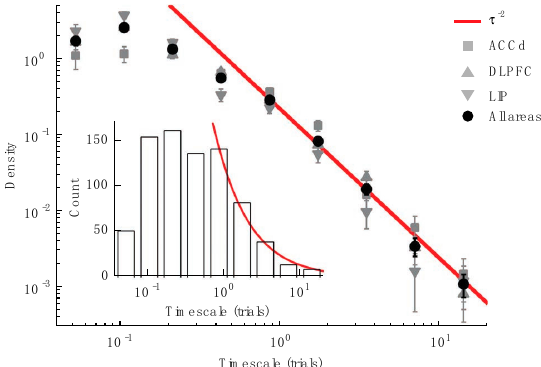
Figure 6. Multiscale Temporal Representations in Single Unit Activity. A figure panel from Bernacchia et al. (2011) The x -axis shows the time scale (in number of trials) in which past experiences can a ff ect the firing rate. The y -axis indicates the probability density distribution of neurons having di ff erent time scales. The densities left of the point of 10 0 = 1 trial shows the neurons with time scales shorter than a single trial, whereas the densities right of this point imply the neurons with time scales longer than one trial. There are substantial number of neurons showing the traces of memory carrying the information longer than a single trial (Image adapted with permission from Bernacchia et al., Nature Neuroscience, 2011; Nature Publishing Group